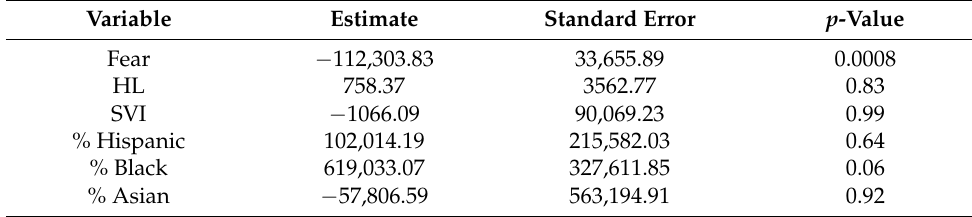
Table 4. The association between vaccination increase and